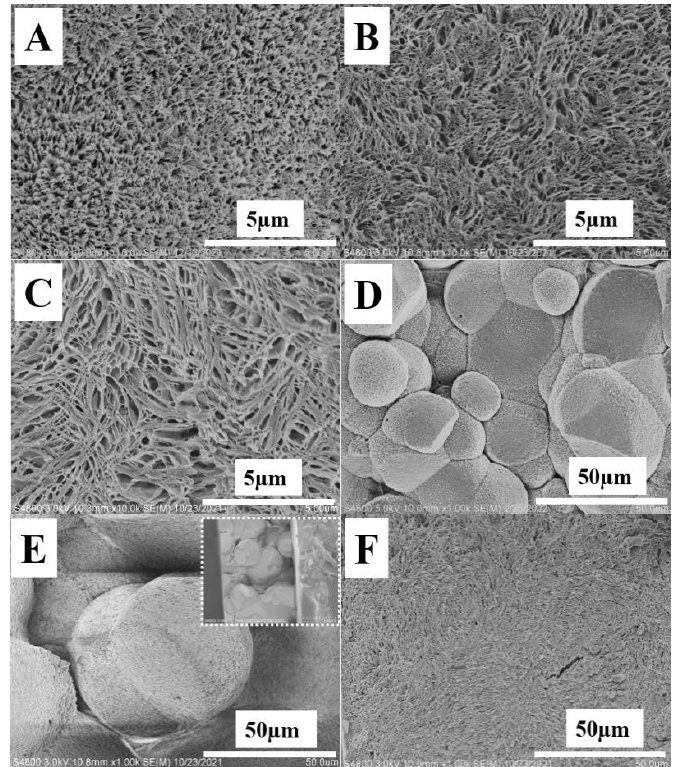
Figure 4. SEM images of PLLA/TAIC (60/40) blend upon etching with methanol on the specimen after complete melt crystallization at 60 ◦ C ( A , D ), 80 ◦ C ( B , E ), and 100 ◦ C ( C , F